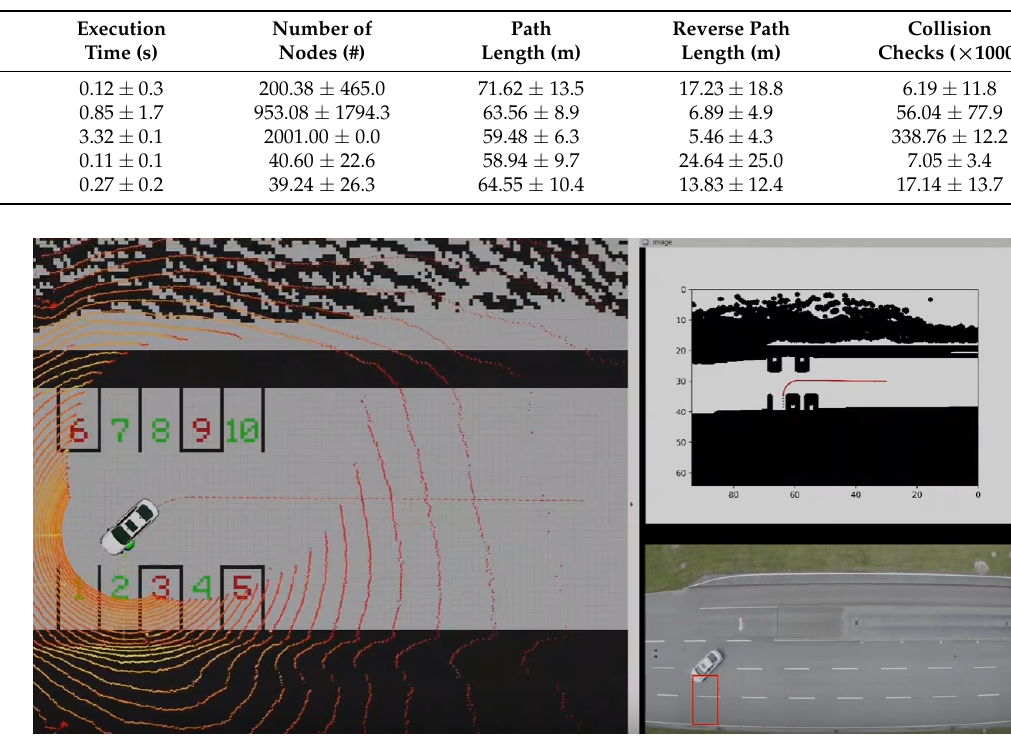
Figure 15. An example test video of the PVLSA demonstrator is available on Youtube, access date: 4 June 2021. The main visualisation on the left shows the localisation and the tracked path during the manoeuvre. On the top right, the dilated occupancy map together with the planned path is shown. The bottom right is the birds-eye view of the vehicle during the